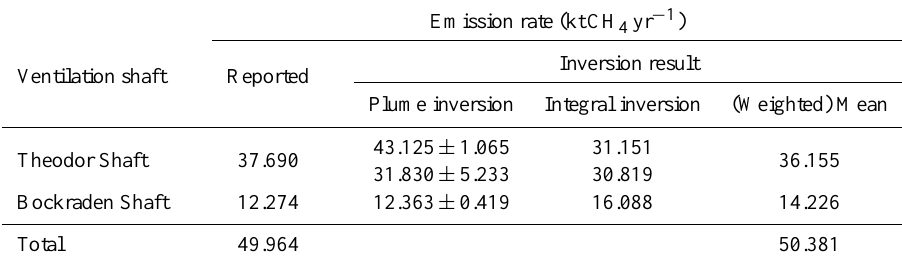
Table 4. Comparison between reported and inferred CH 4 emission rates. For Theodor Shaft, the two lines indicate the near and far part of the plume. The total result refers to the weighted mean of the inversion results according to involved uncertainties. See main text for more information. Reported values have been kindly provided by the district government of Arnsberg ( Bezirksregierung Arnsberg, Abteilung Bergbau und Energie in NRW ).